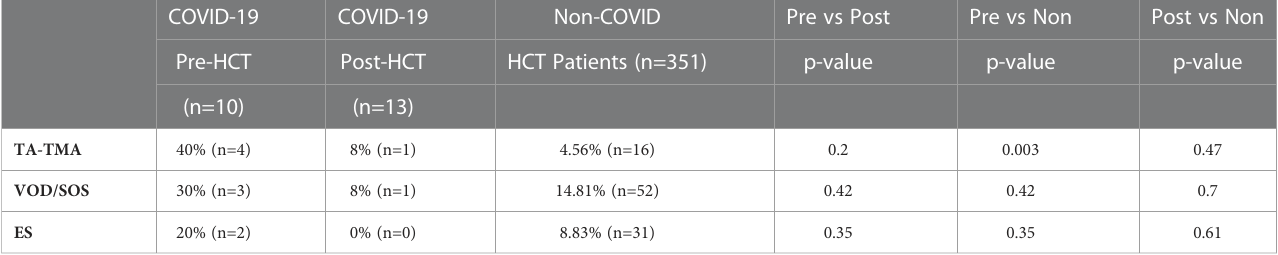
TABLE 3 Incidences of TA-TMA, VOD/SOS, and ES among HCT patients who contracted COVID-19 pre-transplant, post-transplant, or were never